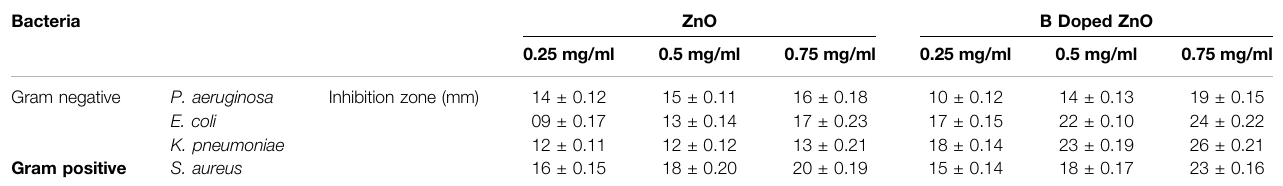
TABLE 1 | Information of bacterial isolates and other experimental parameters. Bacteria